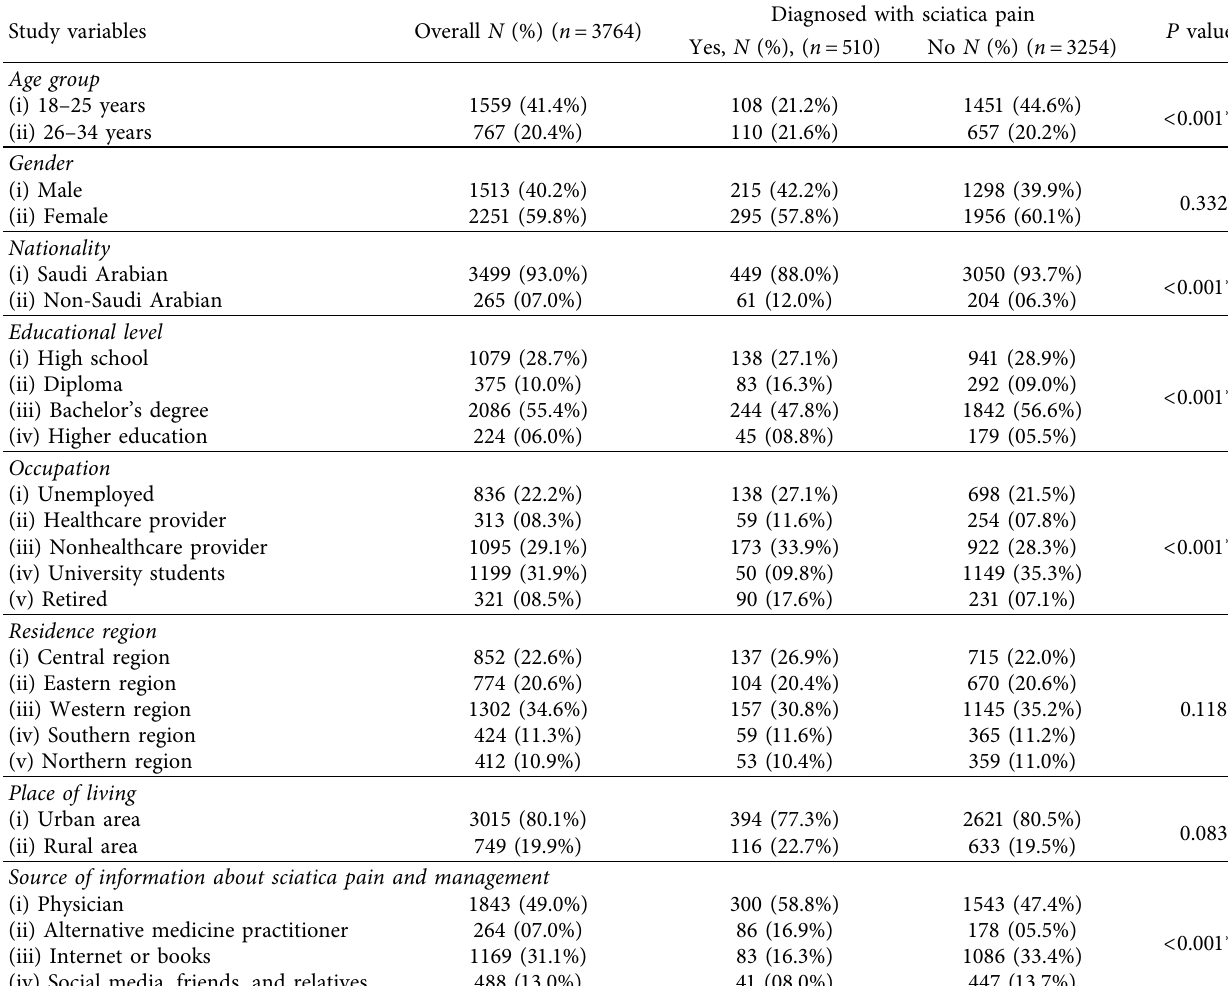
Table 2: Sociodemographic characteristics of participants in accordance to sciatica pain diagnosed by the physician or alternative medicine